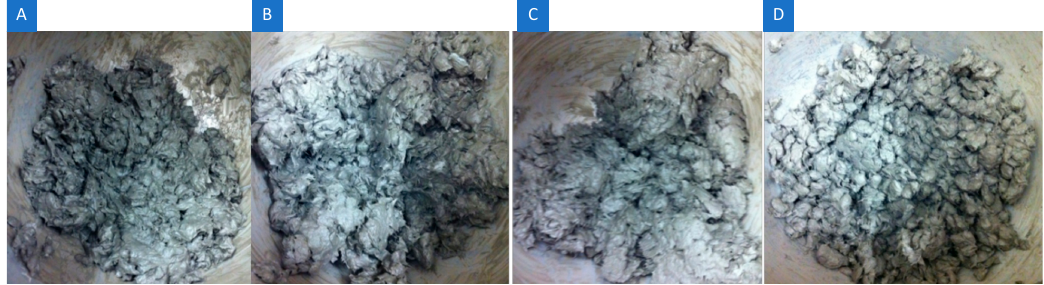
Figure 3. Flow chart of the mixing procedure.